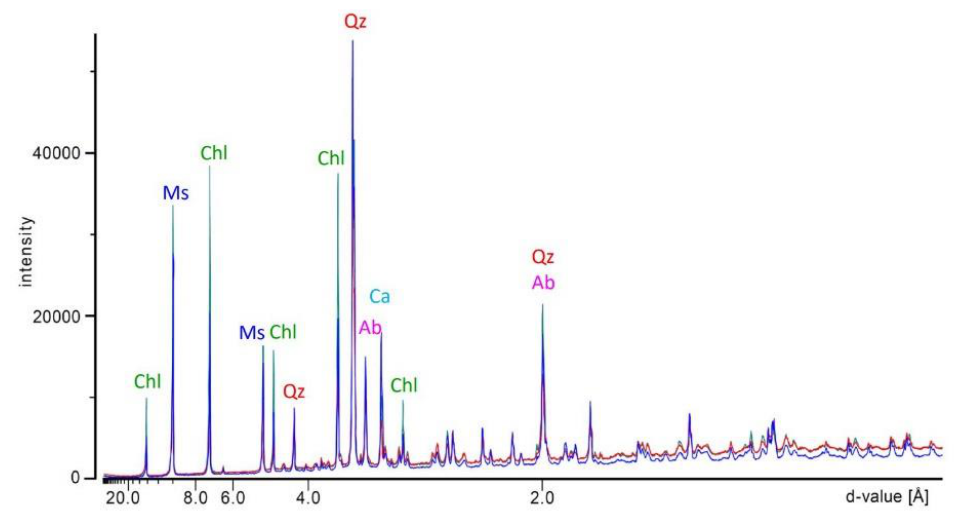
Figure 4. XRD analysis of the fault core sample. The major reflections are caused by quartz, chlorite, albite, calcite, rutile, and muscovite. Three different samples were analysed, shown as blue, red, and green lines.